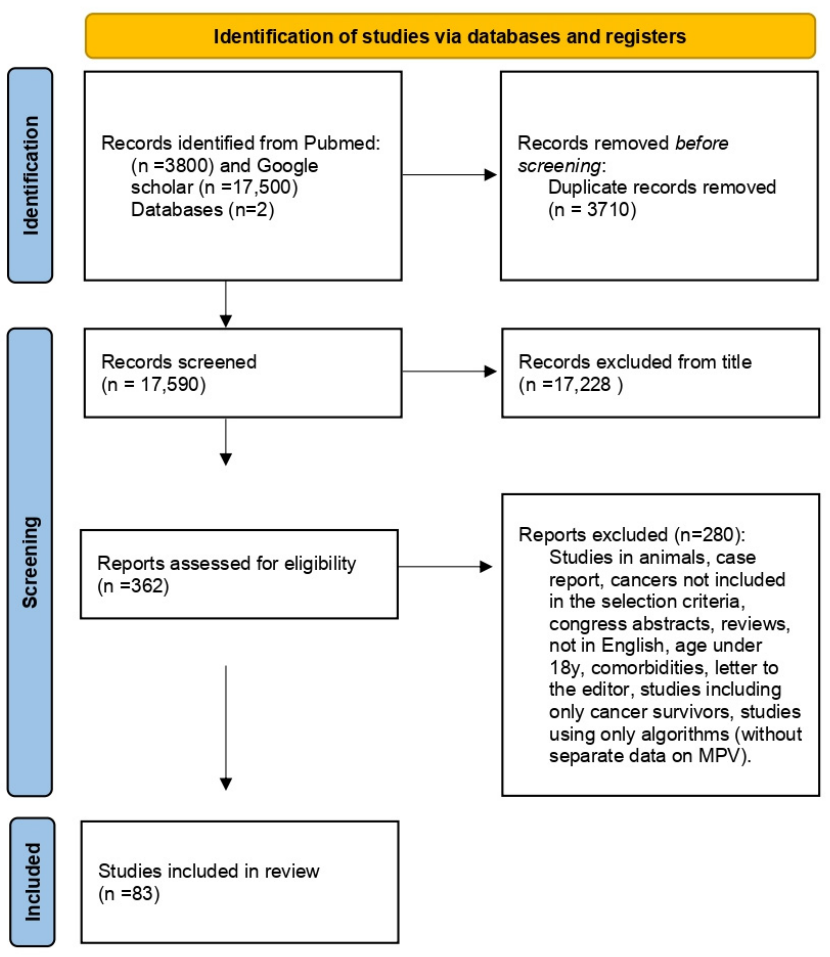
Figure 1. PRISMA flow diagam.